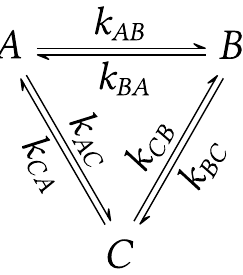
Figure 3. Spin kinetics of three-state